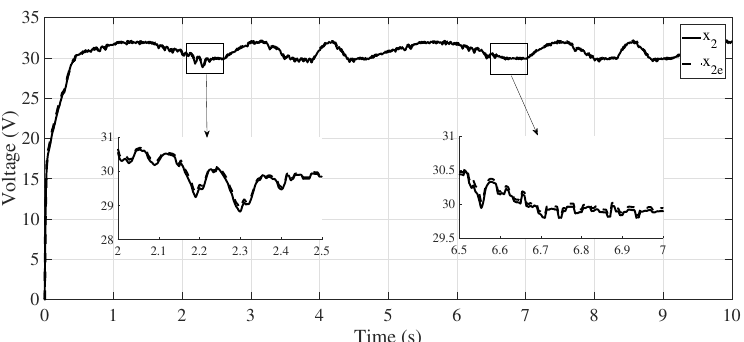
Figure 11. PV current for MPPT test.